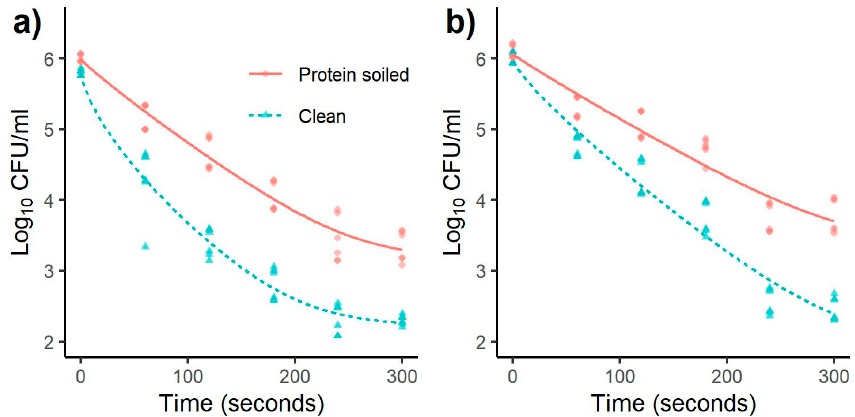
Figure 3. Effect of treatment time on inactivation of Salmonella with a distance of ( a ) 10 and ( b ) 20 mm. Models were fitted using a Weibull + tail inactivation curve (Equation (2)) ( n = 6).